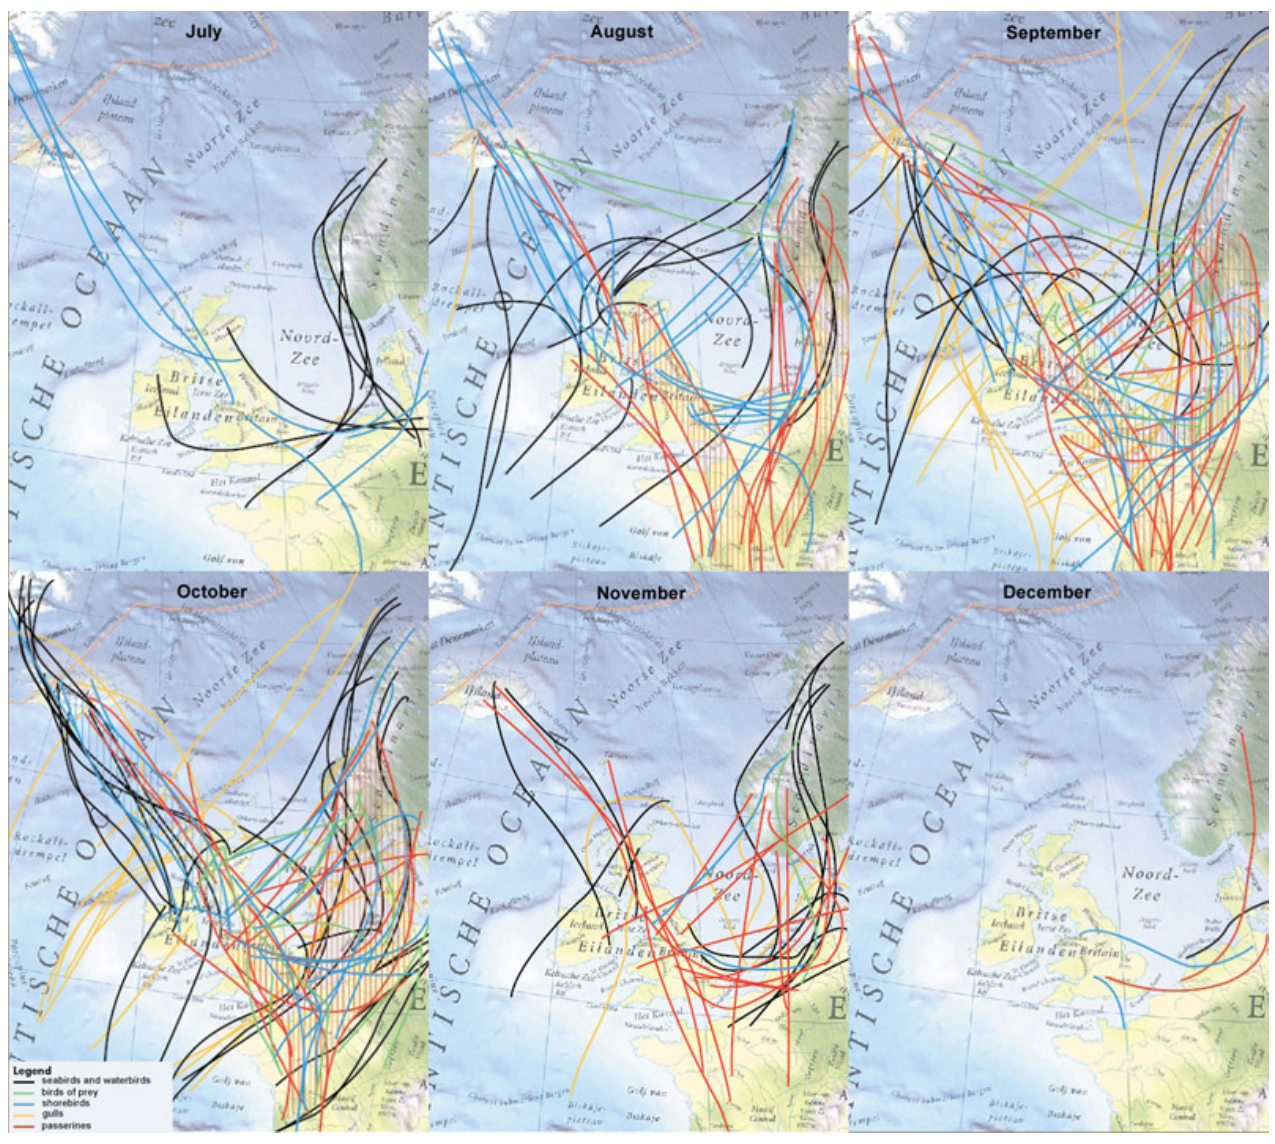
Fig. 2. Schematized maps of the migrations of various bird groups through and around the North Sea area (van de Laar 1999). The following groups are distinguished: seabirds and waterbirds (black lines), raptors (green lines), shorebirds (blue lines), gulls and terns (orange lines), and songbirds (red lines). From top left to bottom right, maps are for July, August, September, October, November, and